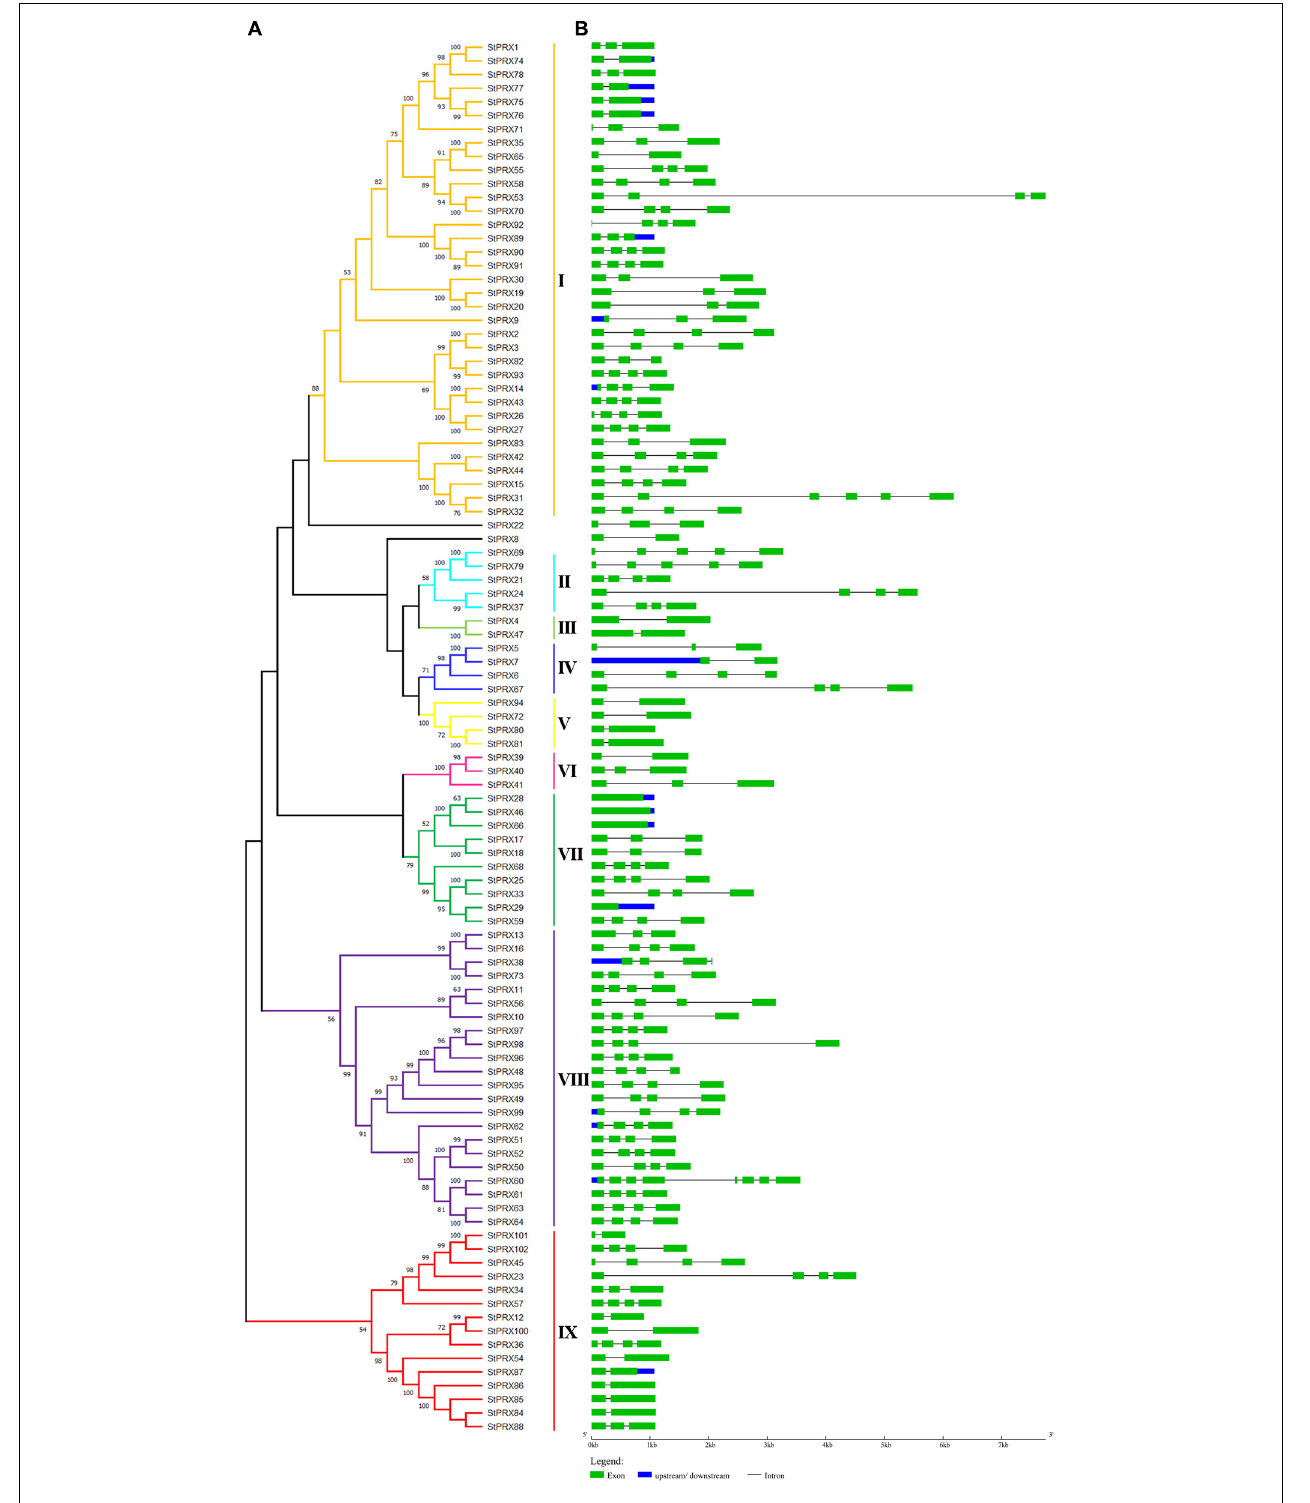
FIGURE 1 | Phylogenetic tree and gene structure of StPRX genes. (A) The maximum-likelihood phylogenetic tree generated by MEGA X with bootstrapping analysis (1,000 replicates). Each subfamily is distinguished by different colors. (B) The exon-intron structure of StPRX genes generated by the online software GSDS. The horizontal black lines and the green boxes represent introns and exons, respectively. The blue boxes represent upstream or downstream sequences. The sizes of exons and introns can be estimated according to the scale at bottom.